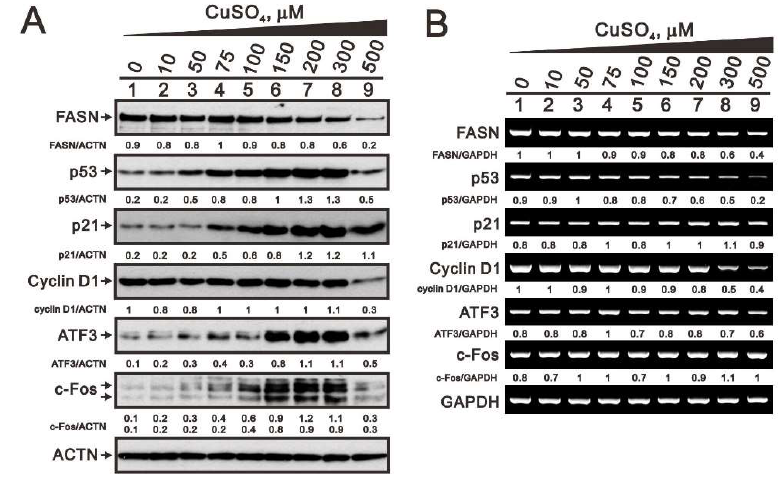
Figure 2. Responsiveness of copper-related factors. ( A and B ) HeLa cells were incubated for 16 h